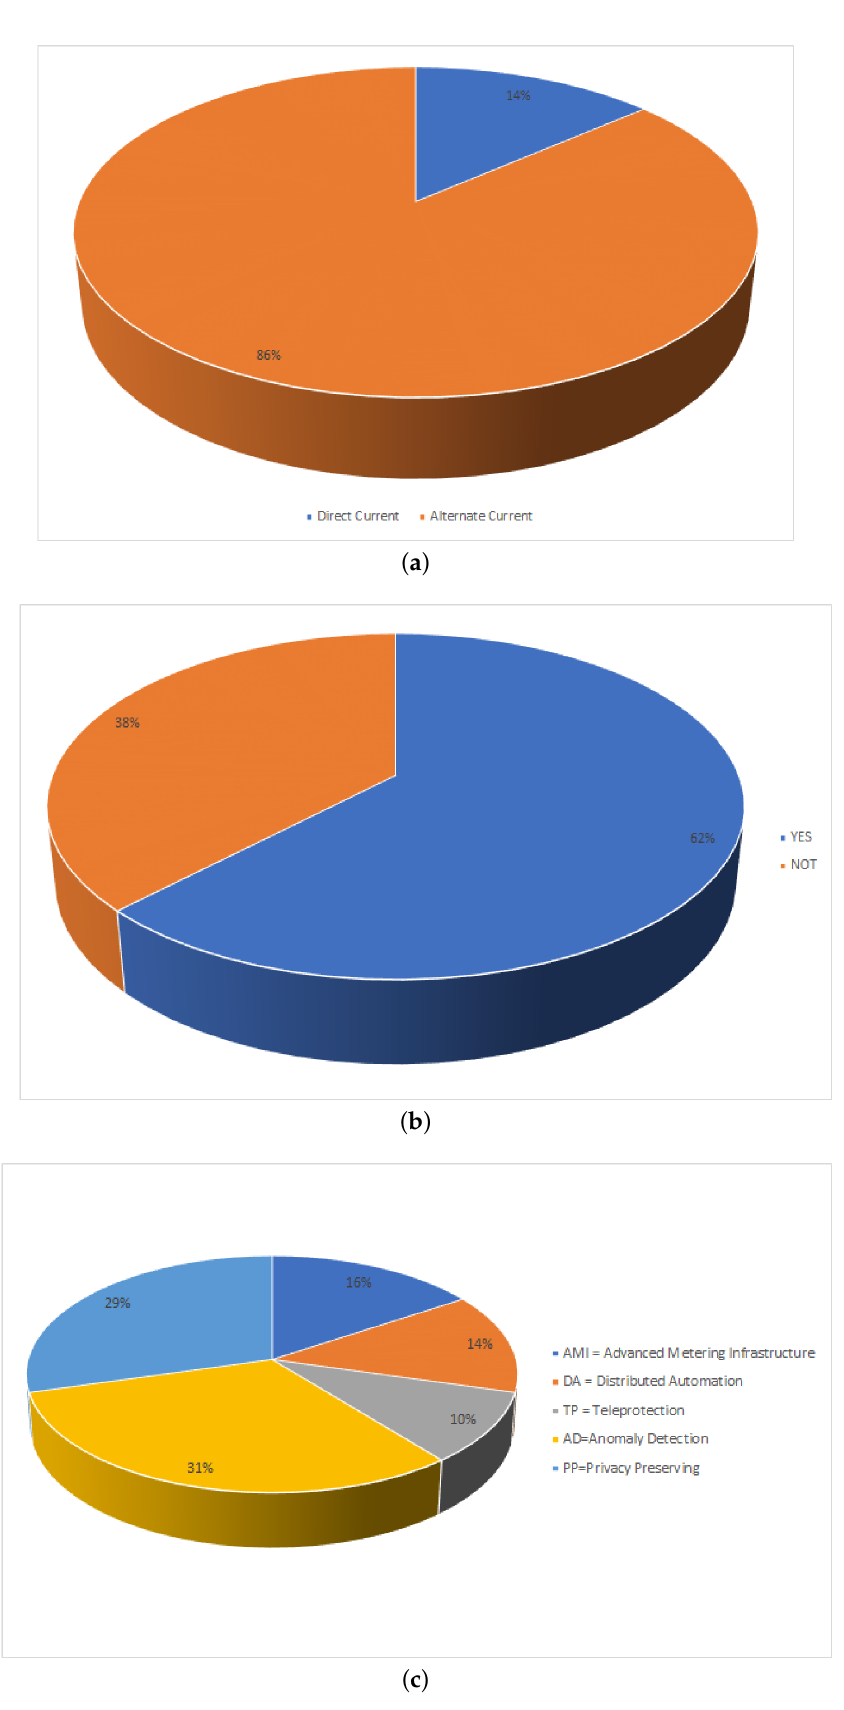
Figure 5. Classification: ( a ) Type of current transmitted by the Smart Grid, ( b ) Data Transmission over a Smart Grid, and ( c ) Applications of Smart